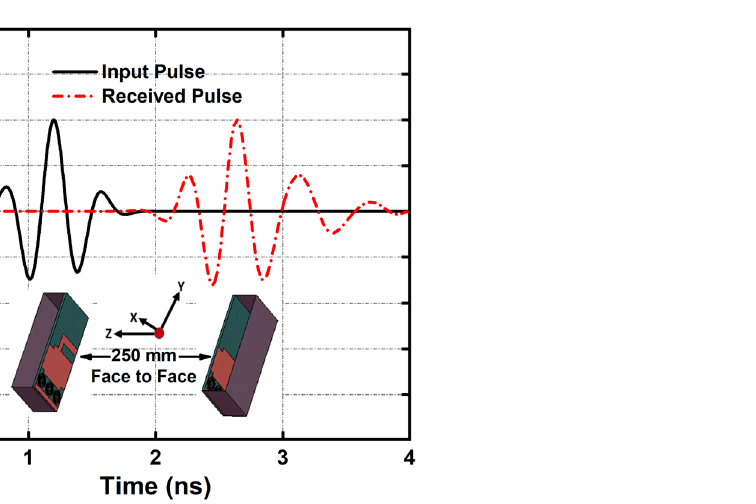
Figure 6. ( a ) Simulated and measured E-plane and H-plane (far-field), and ( b ) Measured E-plane and H-plane (near-field), at 2.2 GHz and 3.34 GHz, respectively.